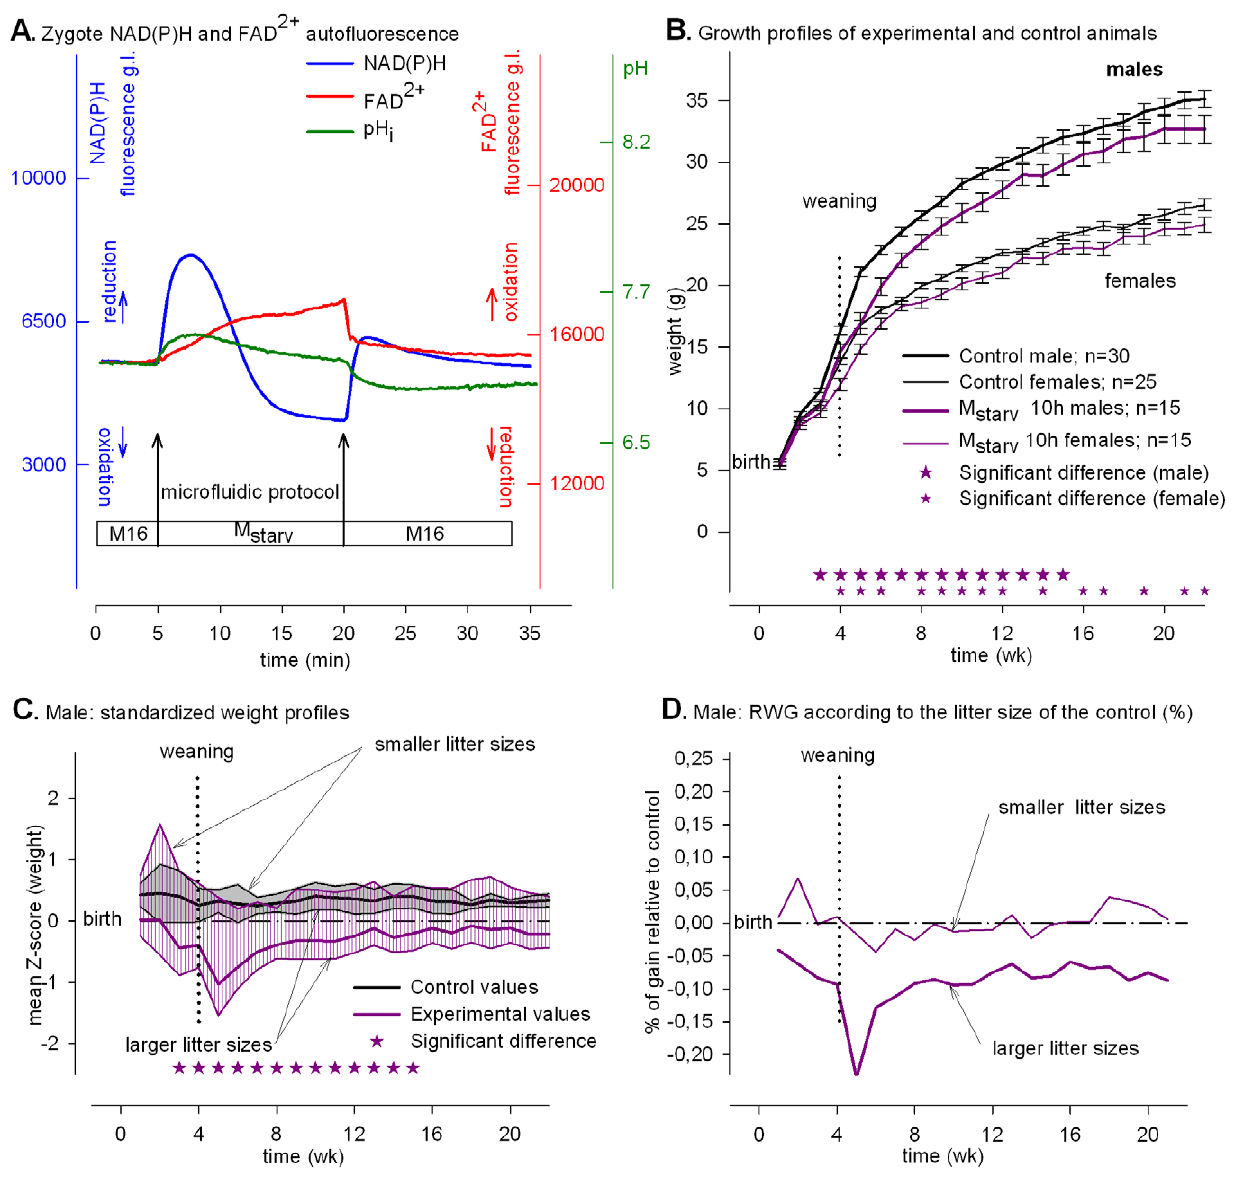
Figure 1. Energy starvation and developmental responses. Metabolic profiles and post-natal phenotypes induced by ‘‘starvation.’’ ( A ) Time course of intracellular NAD(P)H (blue), FAD 2 + (red) signals (grey levels, g.l., 14 bits) and pH i fluorescence (green) of eggs subjected to M starv . The initial NAD(P)H biphasic curve is due to the high lactate/pyruvate ratio in M16 that delays intracellular depletion of carbohydrates. ( B ) Growth profiles of control (black lines) and experimental animals (dark pink lines). The data are expressed as mean 6 SEM. ( C ) Standardized plots of the total Z values (n=210). The upper limits of the shaded zones (grey for controls and dark pink for the experimental values) are the normalized weight profiles of males issued from the larger litter sizes (8, 7 and 6) and the lower limits, from the smaller litter sizes (5, 4, 3 and 2). ( D ) Relative weight gains (RWG) of experimental animals according to the larger or smaller litter size group. In this figure and in figures 2–4, the stars in panels B and C denote significant differences between average experimental and control values (with a P-value at least , 0.04) when compared to controls.